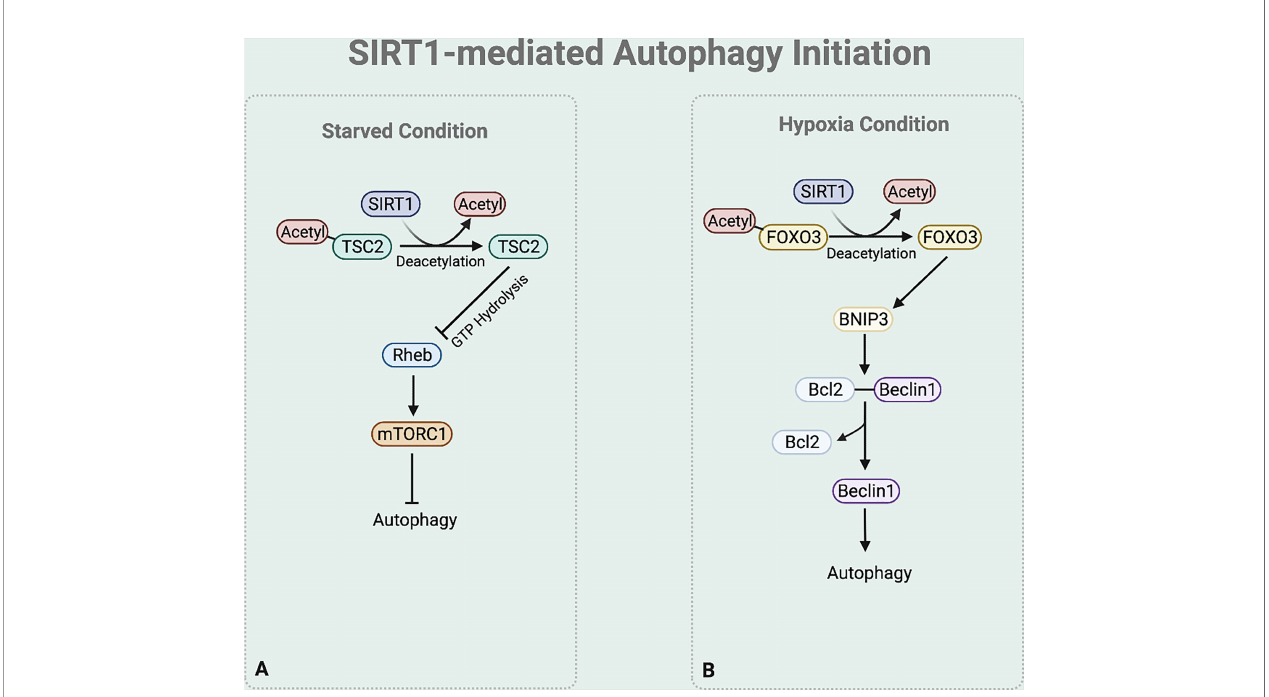
FIGURE 3 | SIRT1-mediated autophagy initiation regulation. (A) Under starved condition, Deacetylase activity of SIRT1 also increases the stability of TSC2 to promote GTP hydrolysis of Rheb. Rheb suppression downregulates the mTOR signaling process. (B) Under hypoxia condition, SIRT1 deacetylases FOXO3 to bind to BNIP-3 promotor and promote BNIP-3